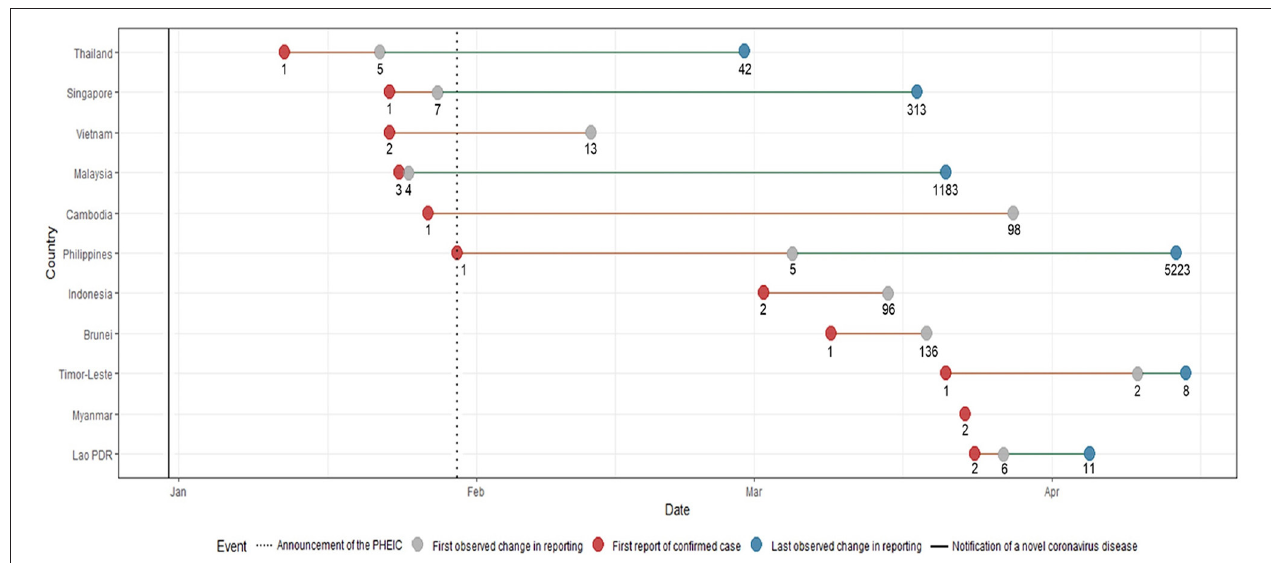
FIGURE 1 | Timeline of key events with corresponding number of cases during the first wave of the COVID-19 pandemic. The notification of a novel coronavirus disease in late December and the announcement of the PHEIC are denoted by lines. Shifts in reporting are defined by a change in level of detail and precision in any of the epidemiological variables ( Supplementary Table 2 ). Each key reporting shift is denoted by a colored circle.